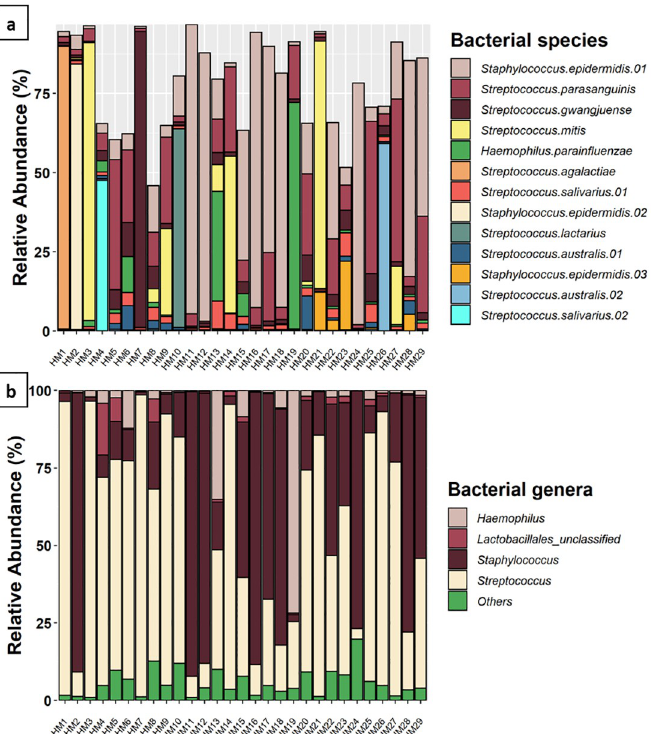
Fig 1. The relative abundance of bacterial OTUs and genera in HM samples. (a) The relative abundance of OTUs which made up � 1% overall relative abundance. Species assigned to each OTU are noted in the legend. Where multiple OTUs mapped to the same species, they are numbered. (b) The relative abundance of bacterial genera which made up � 1% relative abundance across all samples. Genera which accounted for < 1% relative abundance are grouped together as